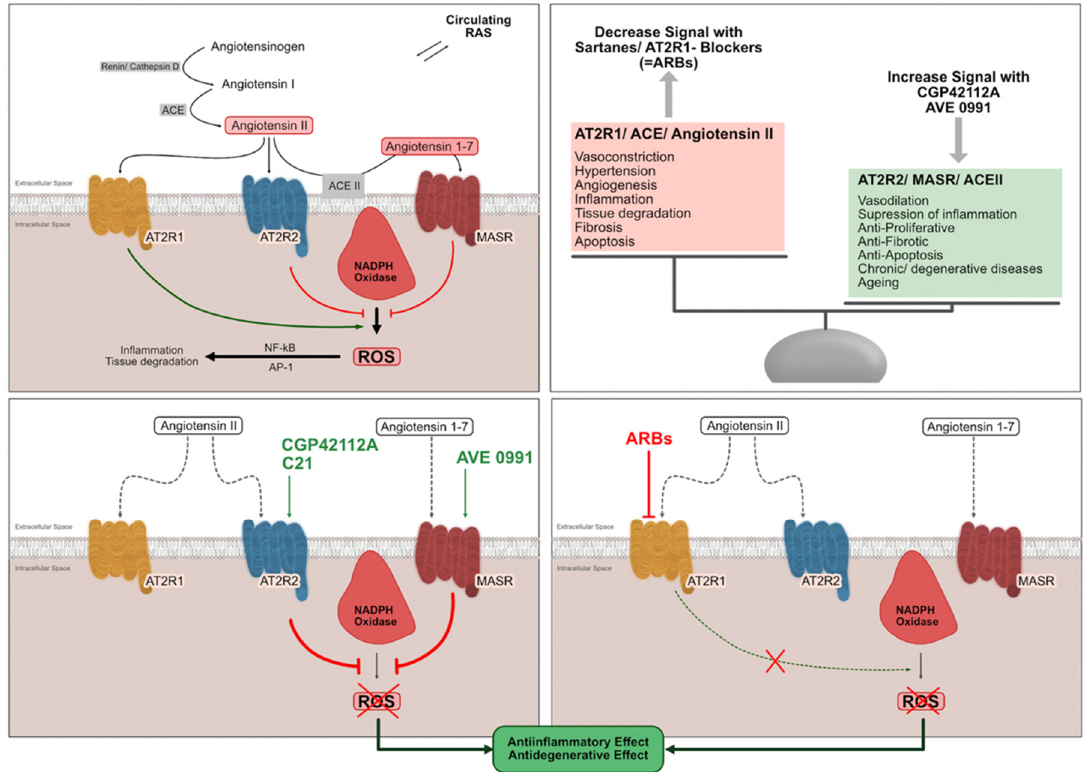
Figure 10. Illustration of tissue renin-angiotensin system (tRAS) mechanisms in humans [11]. Local renin-angiotensin systems are found in human nucleus pulposus cells. The angiotensin II receptor type 2 (AGTR2) and the Ang1–7/Mas receptor (MasR) axis counteract the pro-inflammatory effects (increasing intracellular reactive oxygen species (ROS) of accumulating angiotensin II concentrations (AngII) on angiotensin II receptor type 1 (AGTR1). The inhibition of the pathological axis (AGTR1) and the stimulation of the protective axis could show beneficial effects on the inflammatory and degenerative state of cells. ARBs: angiotensin II type 1 receptor blockers.